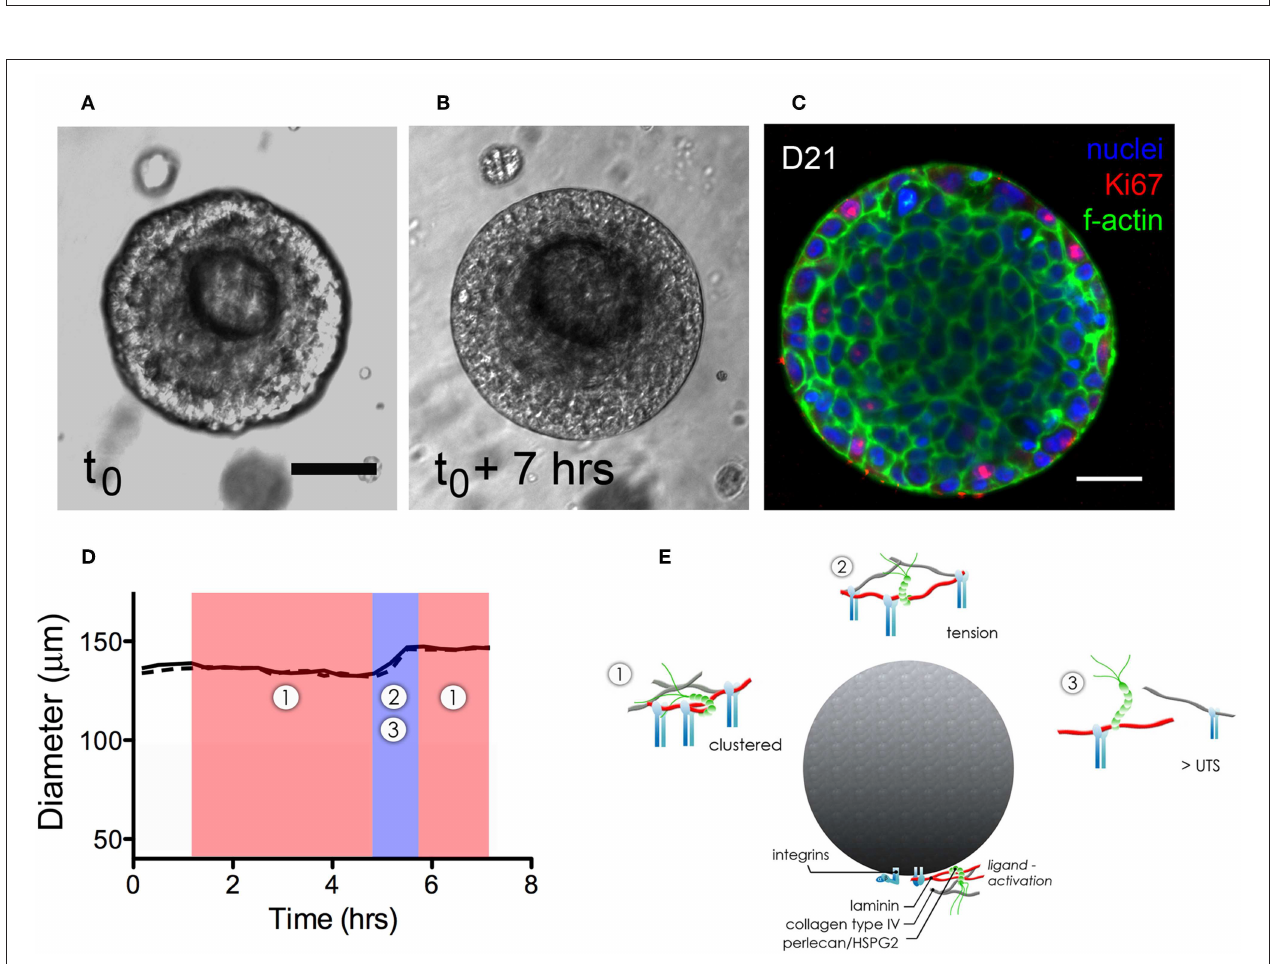
FIGURE 4 | Dynamics of expansion of an hS/PC microstructure in HA-based hydrogel. Non-linear structural expansion was observed over a 7h period (A,B) . Total expansion increased structure volume by 33%. Ki67 staining revealed proliferative cells at the periphery of the microstructure, adjacent to the basement membrane (C) . Dimensional analysis measuring major and minor axes (x-dotted line, y-solid line) in (D) reveals microstructure contraction during phase 1 followed by a growth and tensile phase (2–3) for < 1.5h that visibly stretched and thinned the basement membrane. Schematics of phases 1–3 in (E) focus on integrin-basement membrane interactions. During phase 1, integrins are more tightly spaced when associated with laminin and collagen IV in the basement membrane. Expansion-induced tension on the basement membrane in phase 2 increased periodicity of in-tact integrin attachments reaching tensions large enough to break perlecan spot-welds between laminin and collagen IV networks. Ultimate tensile strength (UTS) of proteins in the basement membrane are approached during phase 3-expansion causing reorganization and subsequently remodeling of the basement membrane as contractile events during phase 1 began. Scalebar = 25 µ m.